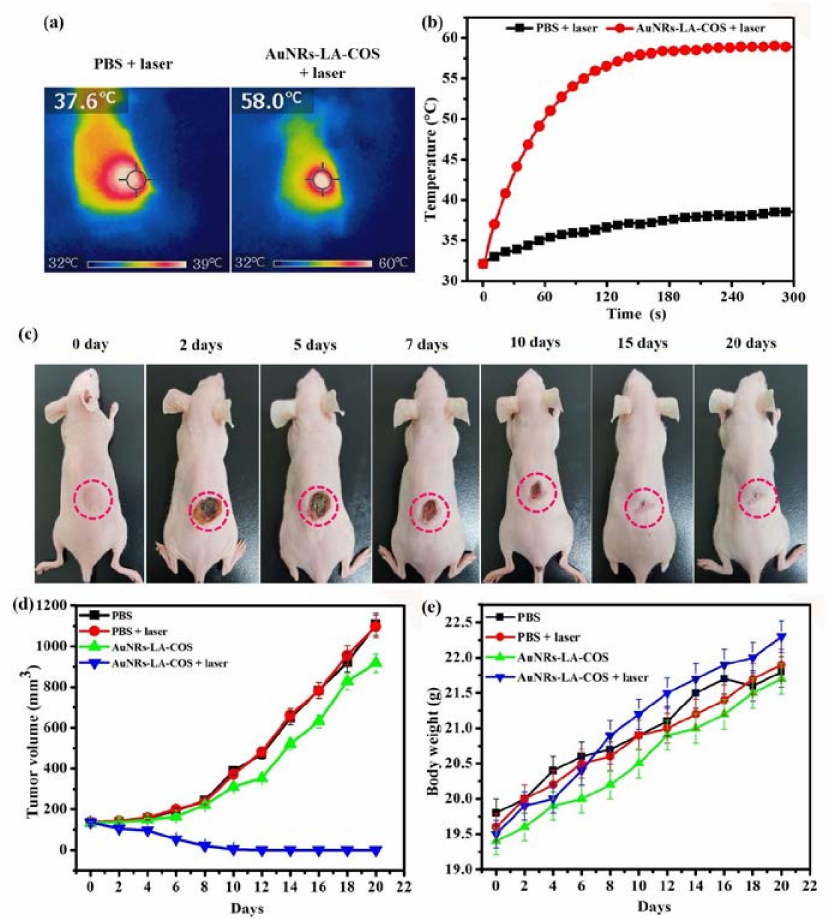
Figure 7. ( a ) IR thermographs of mice injected with the PBS and AuNRs-LA-COS and irradiated with an 808 nm NIR laser at 2 W/cm 2 for 5 min. Thermographs were recorded with an infrared thermal camera as function of irradiation time. ( b ) Temperature changes of tumor-bearing mice after intratumoral injection with PBS and AuNRs-LA-COS with an 808 nm NIR laser at 2 W/cm 2 for 5 min. ( c ) Photographs of mice taken before treatments (0 day) and 2, 5, 7, 10, 15, and 20 days after treatments of AuNRs-LA-COS with an 808 nm NIR laser at 2 W/cm 2 for 5 min. ( d ) The relative tumor volume in different mice groups after photothermal therapy. Data is expressed as mean ± SD of the three experiments. ( e ) Body weight of tumor-bearing mice among different treatment groups after NIR laser irradiation. Data is expressed as mean ± SD of the three